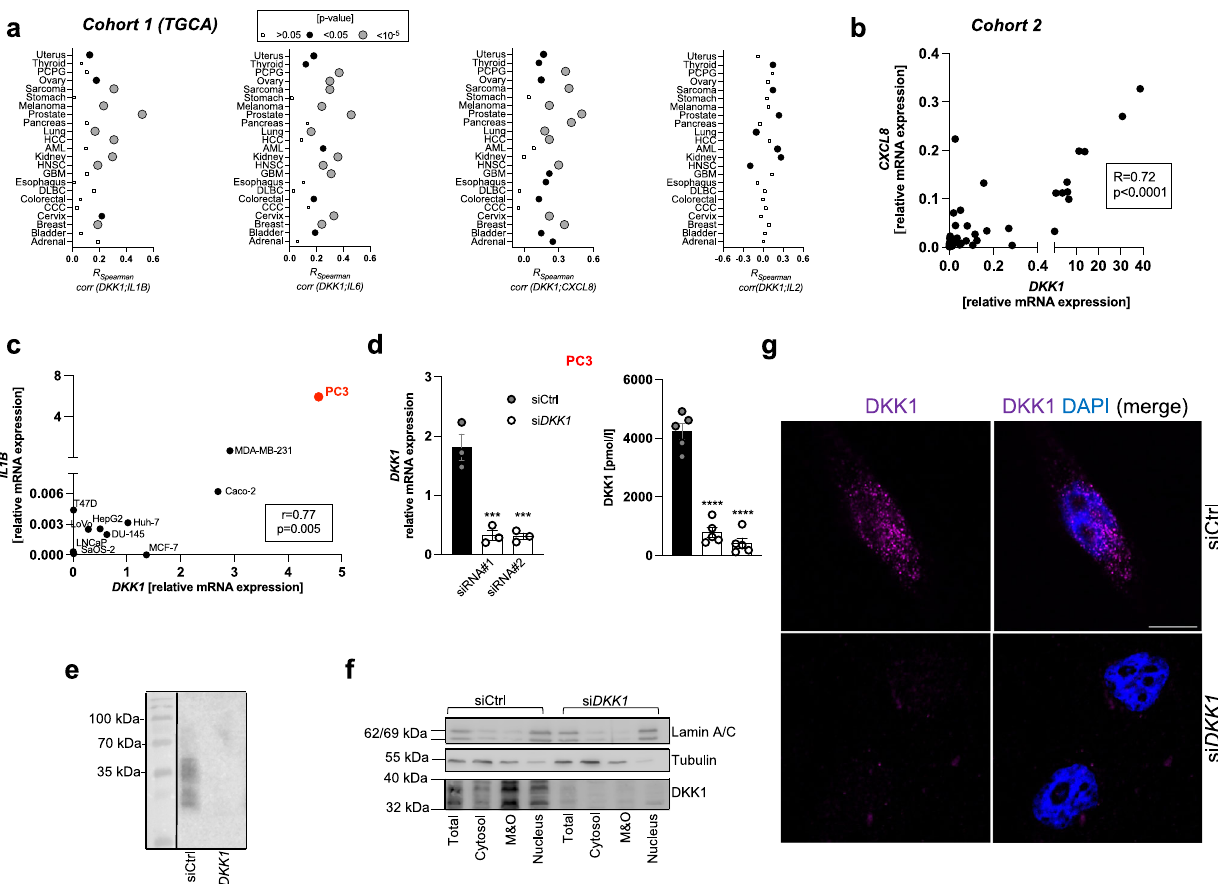
Fig. 1 DKK1 expression associated with in fl ammation in human cancer. a Correlations between transcript levels of DKK1 and selected cyto-/chemokines in human tumor tissues visualized as bubble plots. Each dot indicates the Spearman correlation coef fi cient of the association between DKK1 and cytokine/ chemokine expression in the corresponding tissue (see X-axis). The size of the dot corresponds to the respective p value, whereby larger dots re fl ect smaller (signi fi cant) p values. No threshold for statistical signi fi cance was prede fi ned. Data were extracted from the Cancer Genome Atlas Project